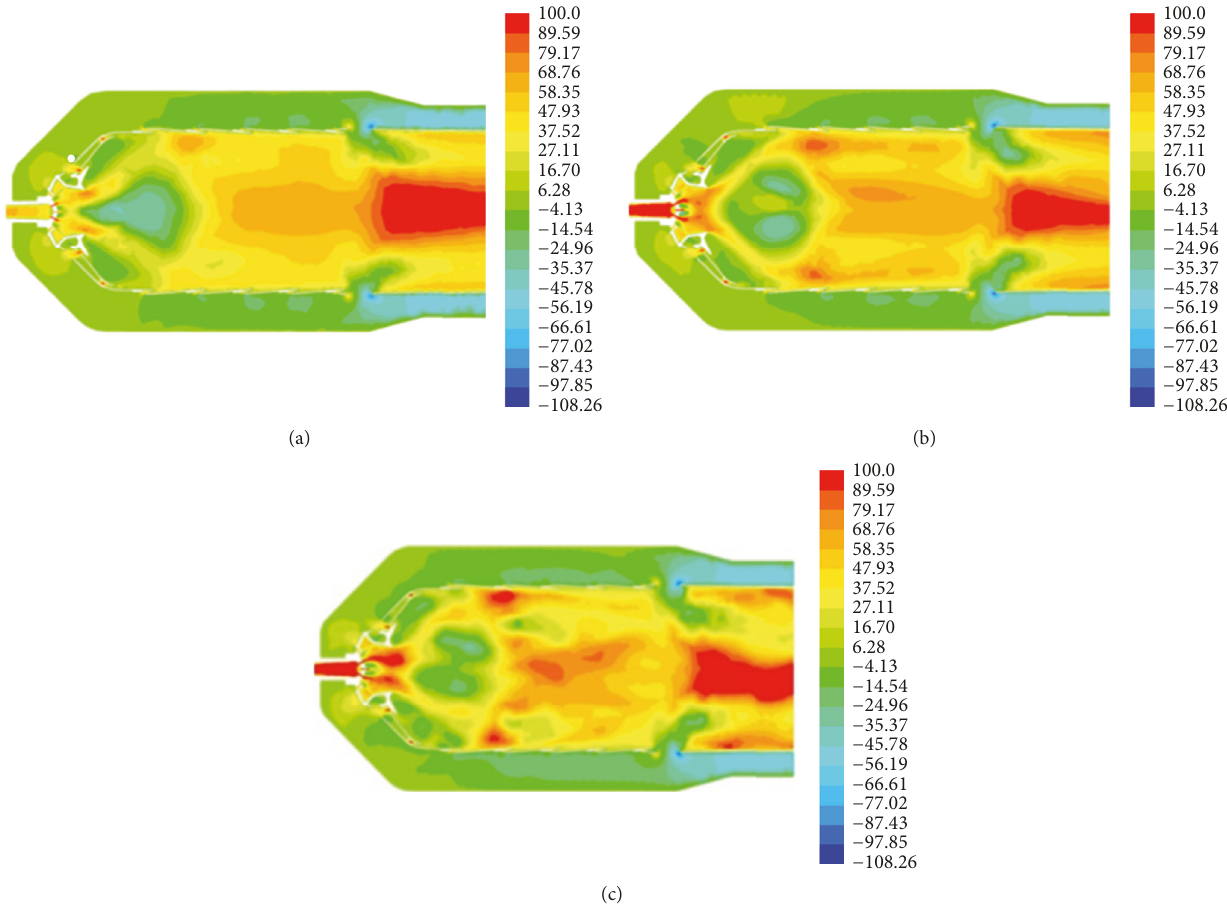
Figure 6: Distribution of the axial velocity component in the longitudinal section, m/s: (a) variant 1; (b) variant 2; (c) variant 3.